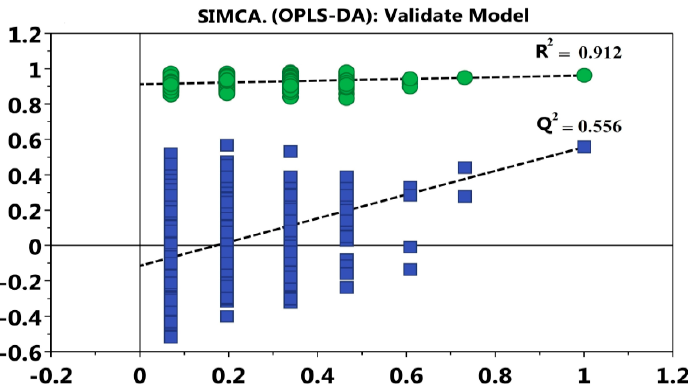
Figure 7. Validation of the OPLS-DA model using a permutation test. The permutations were performed, and the resulting R 2 and Q 2 values were plotted. Green circle: R 2 ; blue square: Q 2 . The green line represents the regression line for R 2 and the blue line for Q 2 .